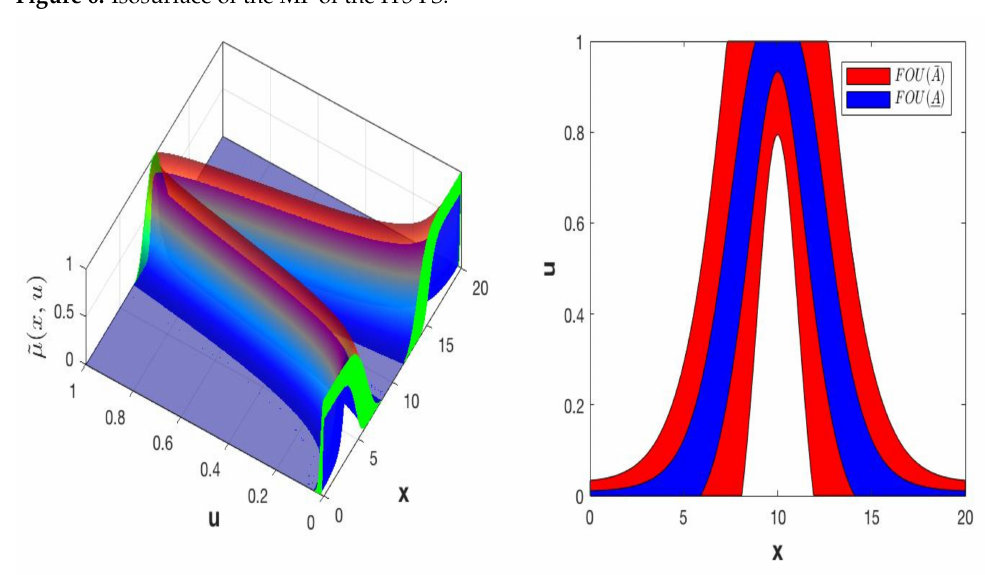
Figure 7. The isosurface of the left plot shows the IT3 MF of an IT3 FS and the right plot shows the FOU ( A ) , where FOU ( A ) ⊆ FOU